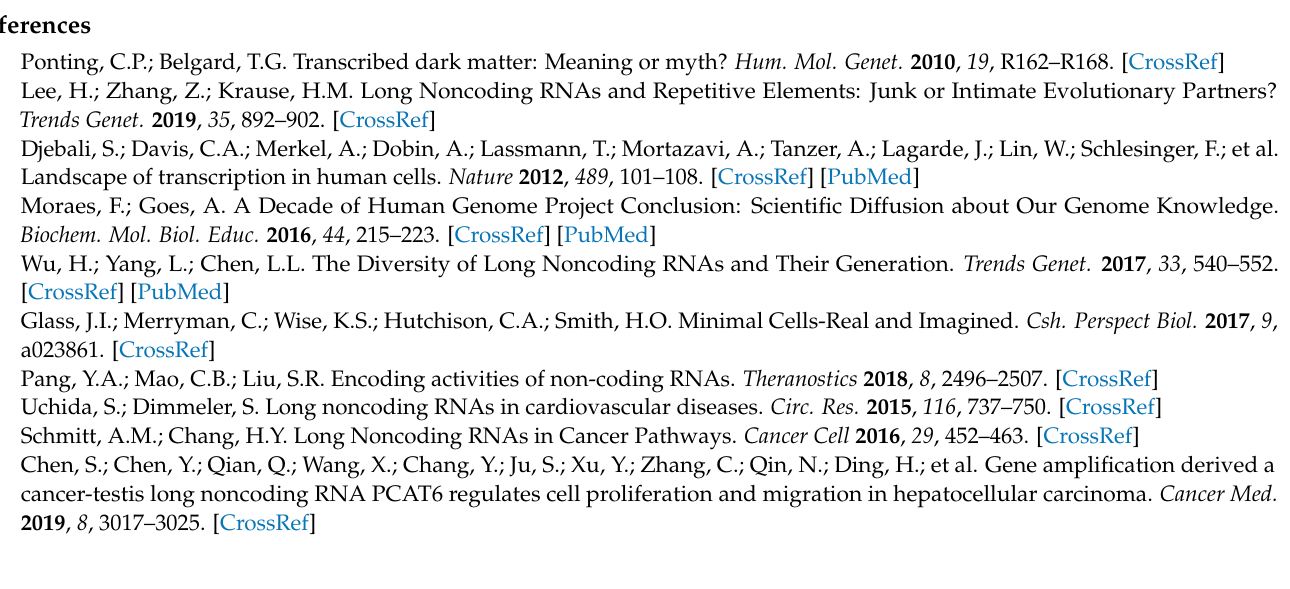
lncRNA THOR gene in mouse, humans, pig, rabbit and zebrafish. Figure S2: The expression of a new truncated THOR . Using qRT-PCR primers outside of THOR deletion region. Table S1: The primers of potential off-target sites (POTS) used in this study. Table S2: Reproduction of the offspring of mouse within 6 months. Table S3: Primer. Table S4: